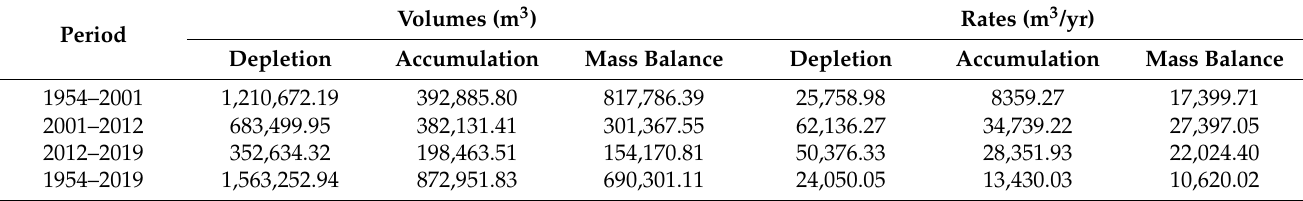
Table 6. Estimation of volume differences between 1954, 2001, 2012, and 2019